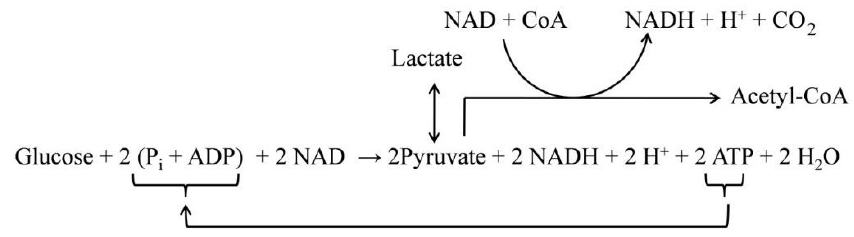
Figure 1. Simplified diagram presenting participation of the ATP in glycolysis—the input pathway in energy metabolism in neurons (for review see Reference [45]). The ATP produced in the mitochondrial process of oxidative phosphorylation is used in neurons as the rate-limiting factor of glycolysis. In this entry process, each molecule of glucose 6-phosphate is broken down into two molecules of pyruvate, which are then used as a source of energy.The chronic decline in ATP production results in neuronal insensitivity to glucose that eventually terminates the cellular energy metabolism.